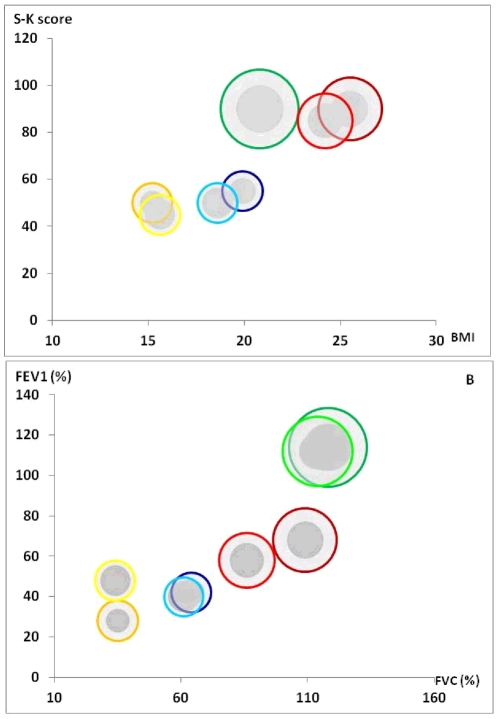
Relation between species richness and clinical status (A) or lung function (B).Total richness of prokaryotic and fungal communities from each patient-sample was expressed using the Chao1 richness estimator; each spot size is proportional to the corresponding Chao1 value. The clinical status is expressed as S-K score and BMI in Figure 2A, while lung function is expressed as FEV1 and FVC values in Figure 2B. Given to the absence of S-K score value from Patient 2-sample 2 (Table 1), this spot is missing in Figure 2A. Bacterial and fungal Chao1 values corresponding to Patient 1, Patient 2, Patient 3, and Patient 4 are represented in blue-, green-, red- and yellow-edged spots, respectively. Dark and light colour intensity is corresponding to the first and second sampling dates of each patient, respectively. Dark grey and light grey are corresponding to fungal and bacterial Chao1 richness values, respectively.